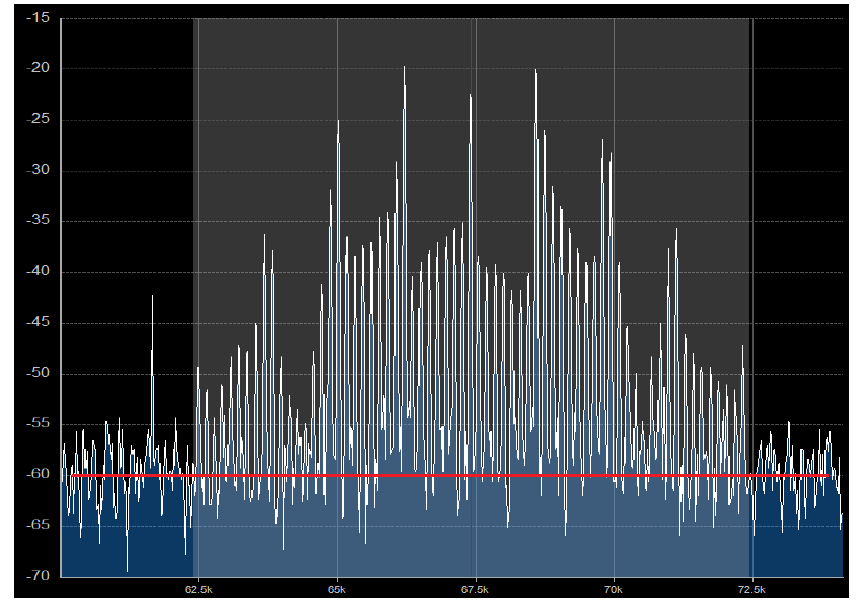
Figure 2. S/N 0 measurement example . Figure 2. S / N 0 measurement example.